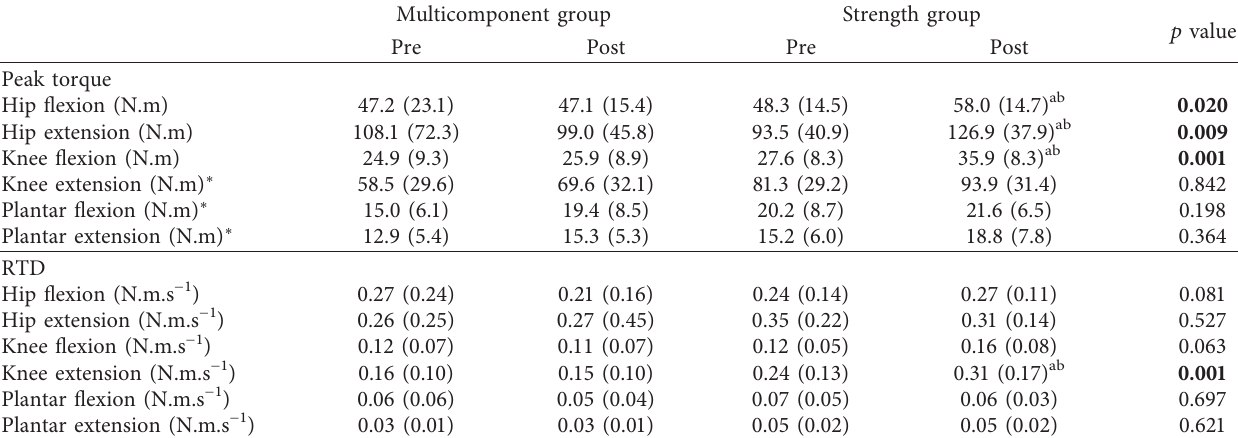
Table 1: Peak torque and rate of torque development around ankle, knee, and hip joints during maximal voluntary isometric contraction for multicomponent and strength groups at pretraining and posttraining.